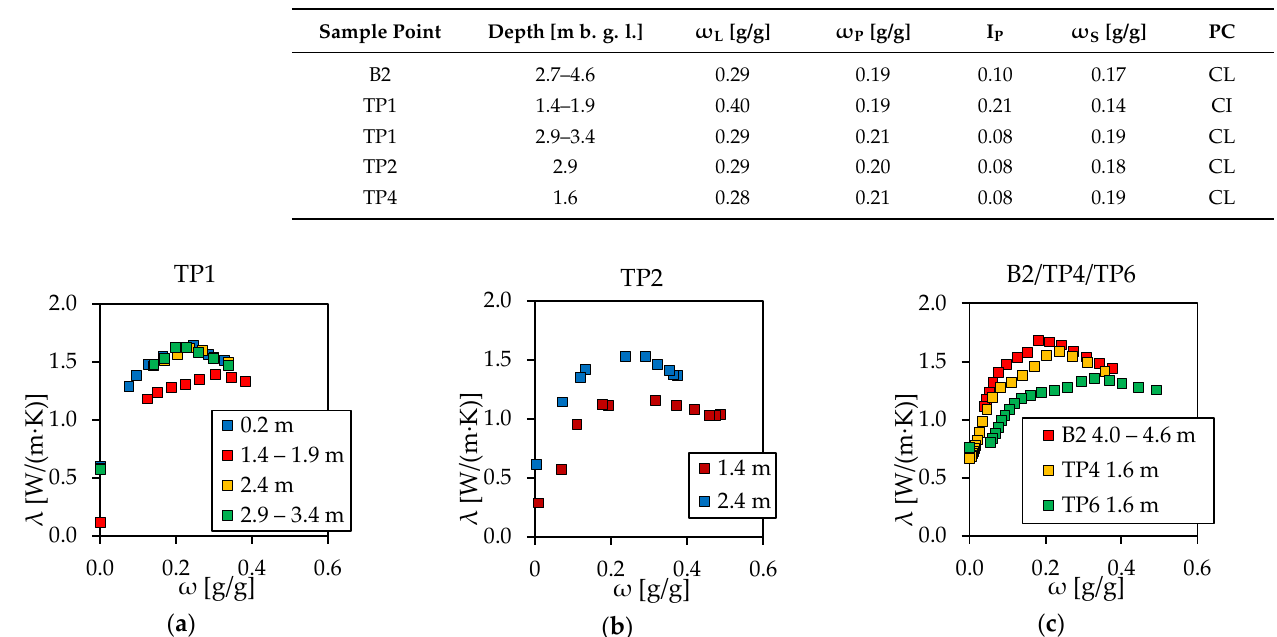
Table 7. Observed bulk density changes during saturation and drying using the evaporation method: ρ b_ini = initially installed bulk density, ρ b_sat = bulk density after saturation, ρ b_dry = bulk density after oven drying. Due to the not completely straight surface of the soil body after swelling and shrinking, the indication of ρ b_sat and ρ b_dry is kept rough.